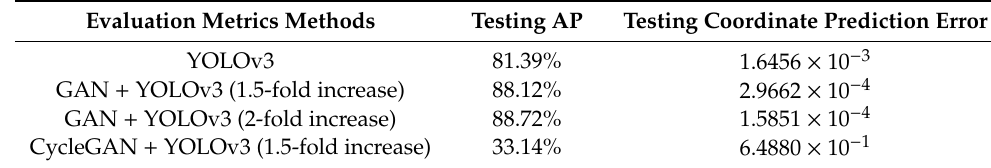
Figure 8. Precision–recall (PR) curve for each method. Table 2. Comparison of methods by different evaluation metrics.